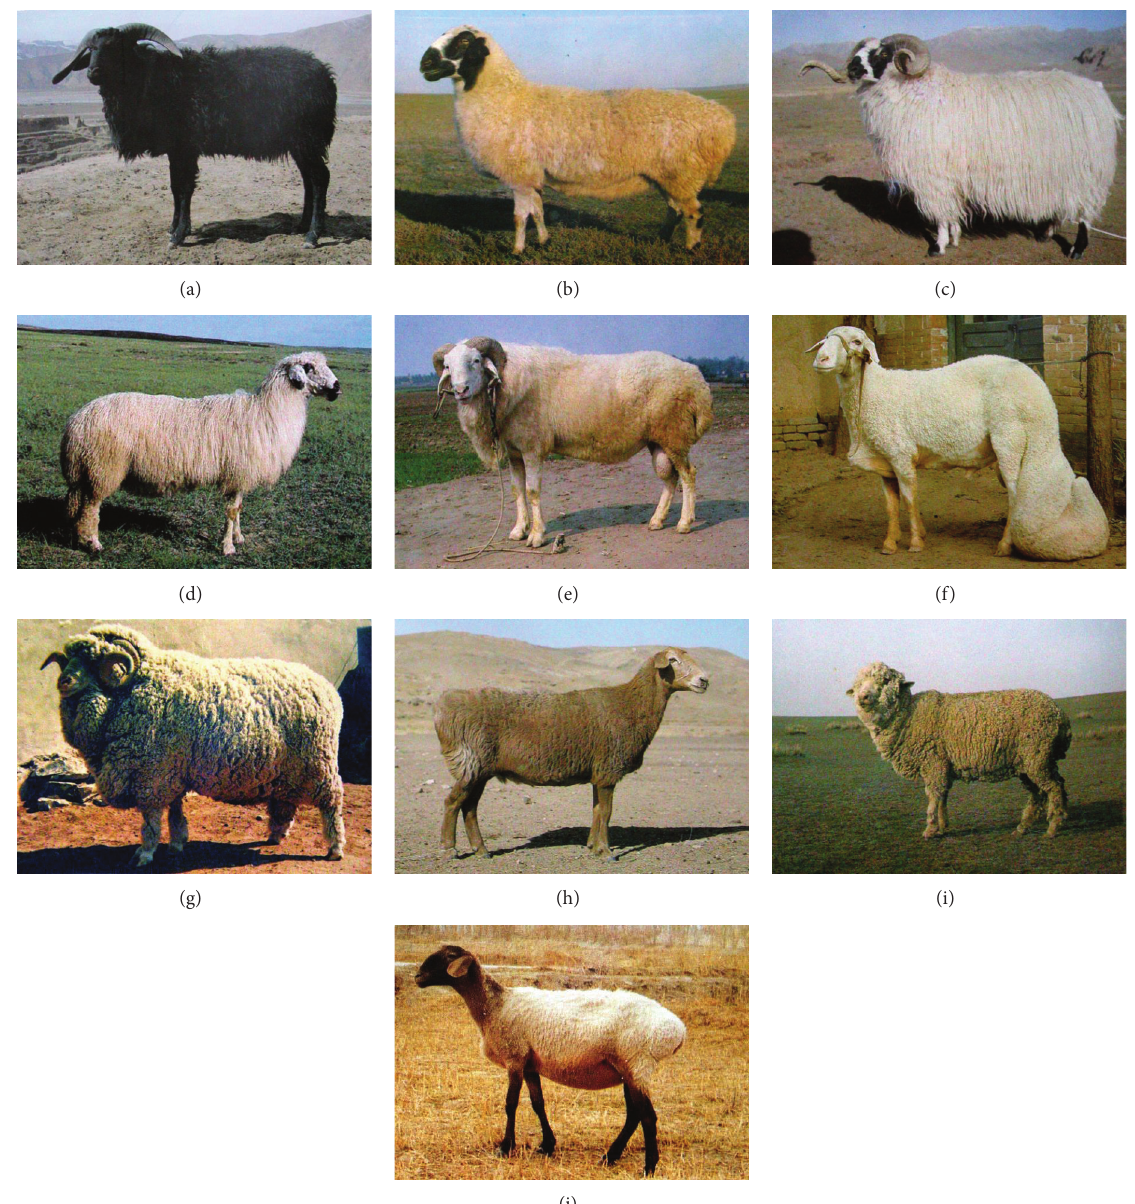
Figure 1: Illustration of sheep coat colors. (a) Minxian Black-fur sheep: black; (b) Mongolian sheep: white coat with black or brown face; (c) Tibetan sheep: white coat with black or brown face; (d) Tan sheep: white coat with black or brown face; (e) Small-tailed Han sheep: white; (f) Large-tailed Han: white; (g) China Merino: white; (h) Kazakh Fat-Rumped: Brown; (i) Gansu Alpine Merino: white; (j) Duolang sheep: white or gray coat with black or brown